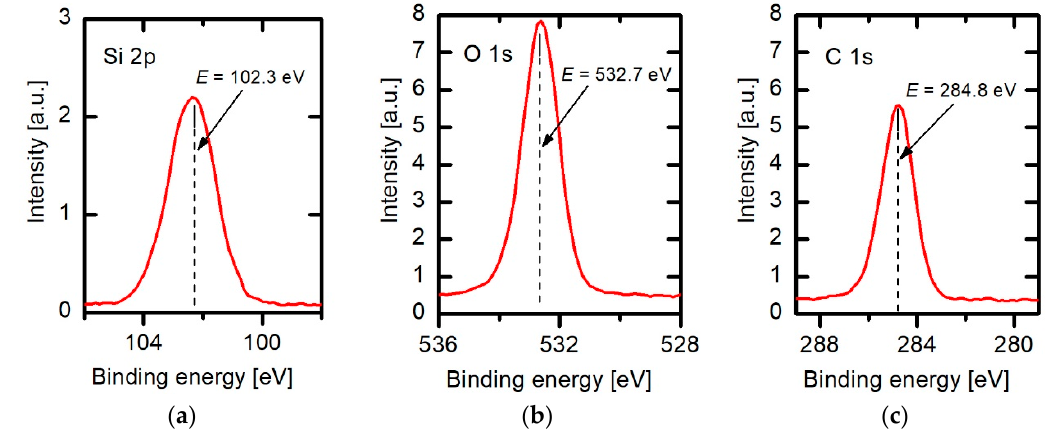
Figure 8. High energy resolution XPS spectra obtained on the surface of the deposited sample of: ( a ) Si 2 p ; ( b ) O 1 s ; and ( c ) C 1 s .